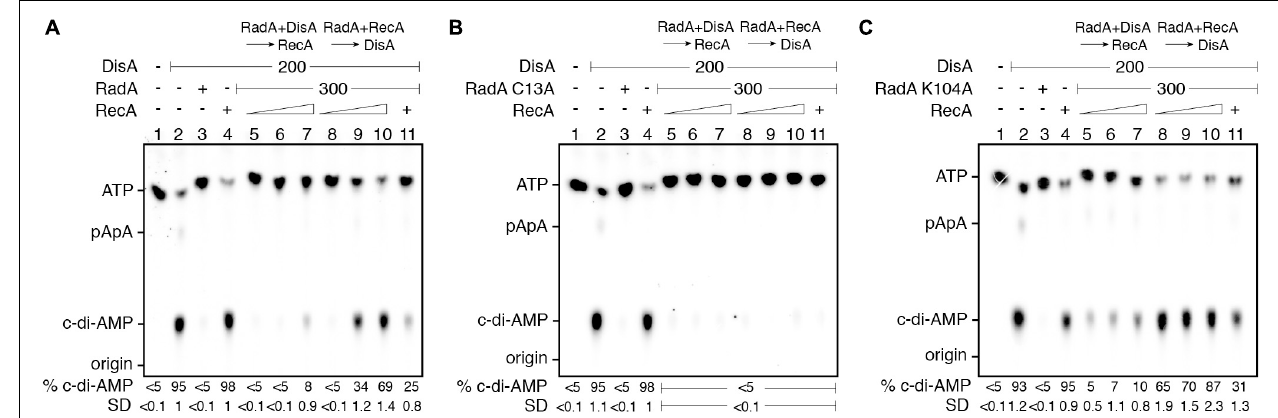
FIGURE 5 | RadA/Sms inhibits DisA DAC activity, but RecA counters this negative effect. DisA (200 nM), or DisA (200 nM) and RadA/Sms (A) , RadA/Sms C13A (B), or RadA/Sms K104R (C) (300 nM), or DisA (200 nM) and RecA (1,600 nM), or DisA (200 nM), RecA (1,600 nM) and RadA/Sms (A) , RadA/Sms C13A (B) , or RadA/Sms K104R (C) (300 nM) were incubated in buffer C containing 100 µ M [ α 32 P]-ATP:ATP (30 min, 37 ◦ C). DisA (200 nM) was incubated with a fixed concentration of RadA/Sms (A) , RadA/Sms C13A (B) , or RadA/Sms K104R (C) (300 nM) (5 min, 37 ◦ C), and then increasing RecA concentrations (400–1,600 nM) were added in buffer C containing 100 µ M [ α 32 P]-ATP:ATP (30 min, 37 ◦ C). Fixed RadA/Sms (A) , RadA/Sms C13A (B) , or RadA/Sms K104R (C) (300 nM) and increasing RecA (400–1,600 nM) concentrations were pre-incubated (5 min, 37 ◦ C), and then a fixed amount of DisA (200 nM) was added in buffer C containing 100 µ M [ α 32 P]-ATP:ATP (30 min, 37 ◦ C). The substrate, intermediates and products were separated by TLC and quantified. The quantification values of c-di-AMP synthesis and the SD of > 3 independent experiments are documented. The position of [ α 32 P]-ATP:ATP, linear pppA-pA (denoted as pApA), c-di-AMP and the origin are indicated.